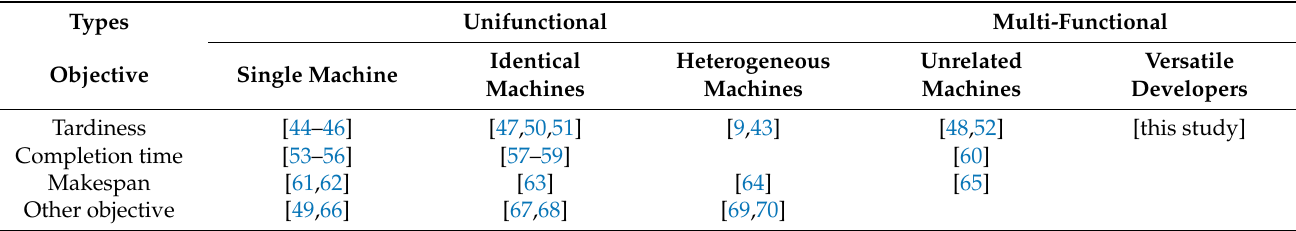
Table 1. Comparisons between different scheduling